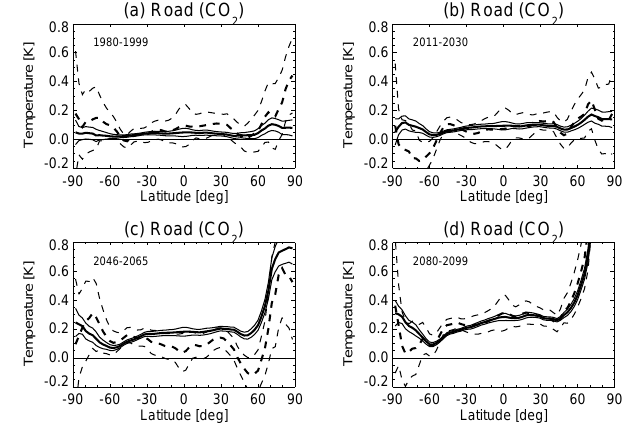
Fig. 14. Annual zonal mean surface air temperature impact from road transport for the periods (a) 1980–1999, (b) 2011–2030, (c) 2046–2065 and (d) 2080–2099 using scaling 1 (dashed lines) and scaling 5 (full lines). The thin lines indicate the 95% confi- dence interval.